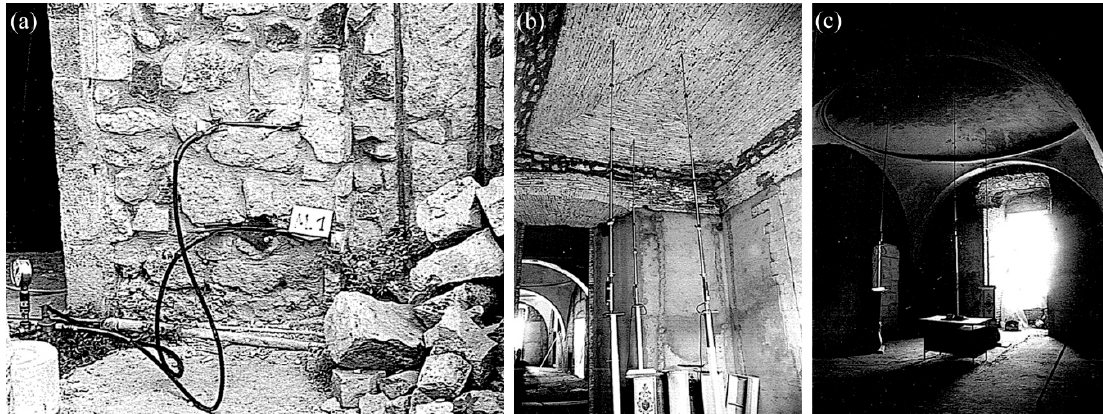
Figure 11. Photographic documentation of the double flat jack tests ( a ) and the floor load tests ( b and c ) from the 1999 survey by Professor P.